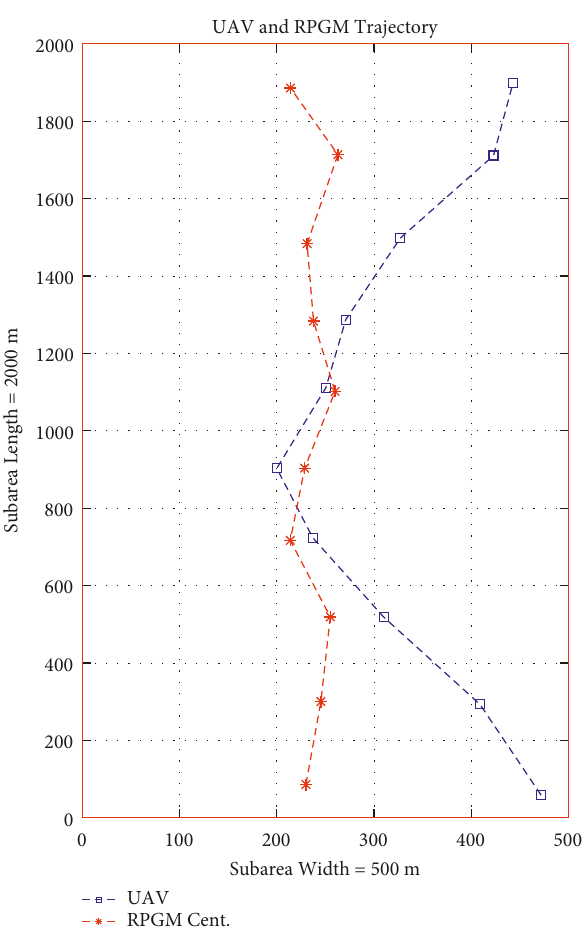
Figure 4: Efficient UAV and RPGM trajectories from T1 to T10.